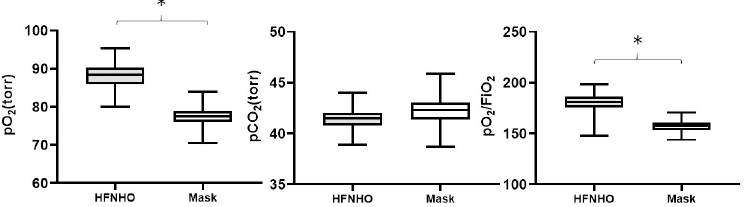
Fig 1. The difference between HFNHO and mask administration group’s SpO 2 (Fig 1A), PO 2 (Fig 1B), and PO 2 /FiO 2 (Fig 1C). Data are mean value ± SD; � p < 0.05.